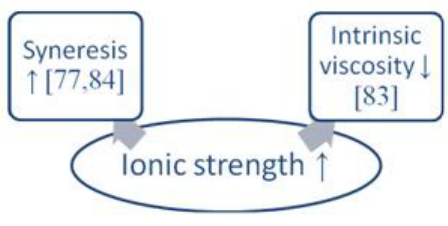
Figure 7. Influence of ionic strength on the physicochemical properties of chitin/chitosan- based